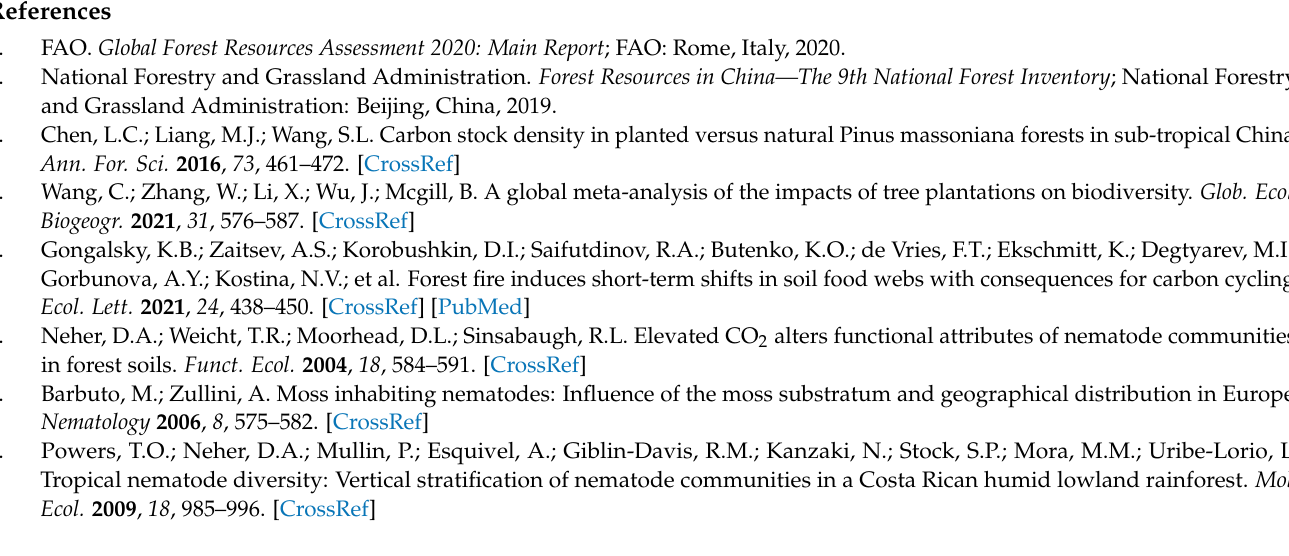
used in production and budget through food web bottom-up (A) and top-down (B) relationships; Figure S2: vertical distribution of relative daily carbon used in production (A) and daily carbon budget (B) of nematodes in subalpine plantation and natural forests; Figure S3: incremental percentage (%) of plantations than natural forests. DP: daily carbon used in production; DB: daily carbon